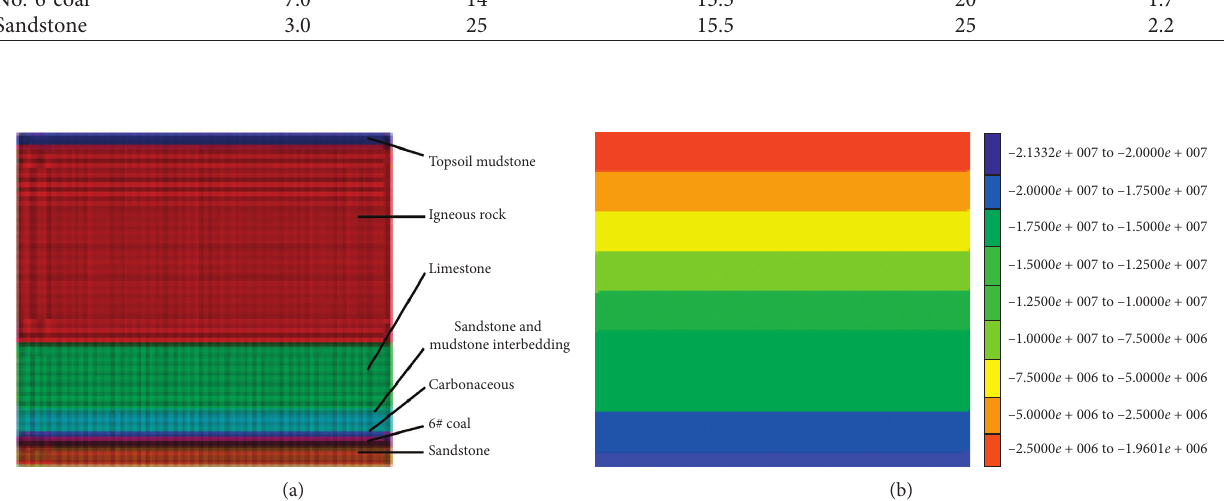
Figure 6: FLAC3D numerical analysis model. (a) Cell divisions. (b) Initial horizontal stress distribution.